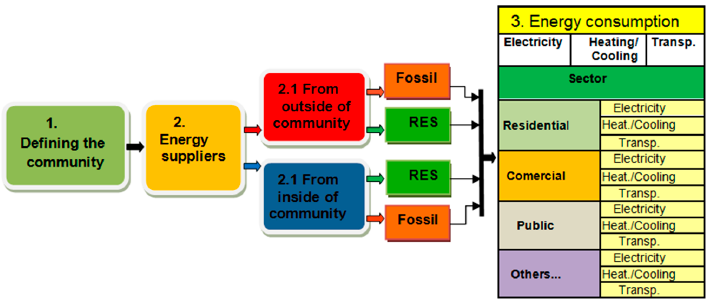
Figure 6. The chart of the data collection for energetic assessment.